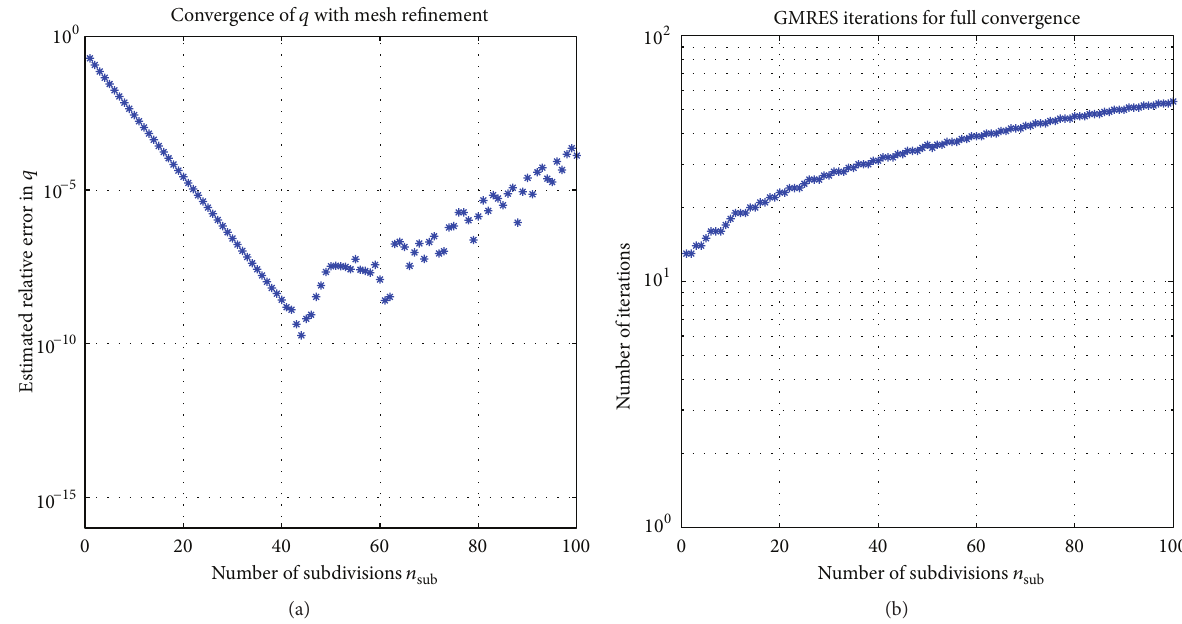
Figure 3: Convergence for 𝑞 of (6) using (8) and the program demo1b.m (a loop of demo1.m ) with lambda = 0.999 , theta = pi/2 , npan = 10 , and evec = 1 . The reference value is 𝑞 = 1.1300163213105365 . There are 𝑛 . (b) The number of iterations needed to meet an estimated relative residual of 𝜖 system. (a) Convergence with 𝑛 sub